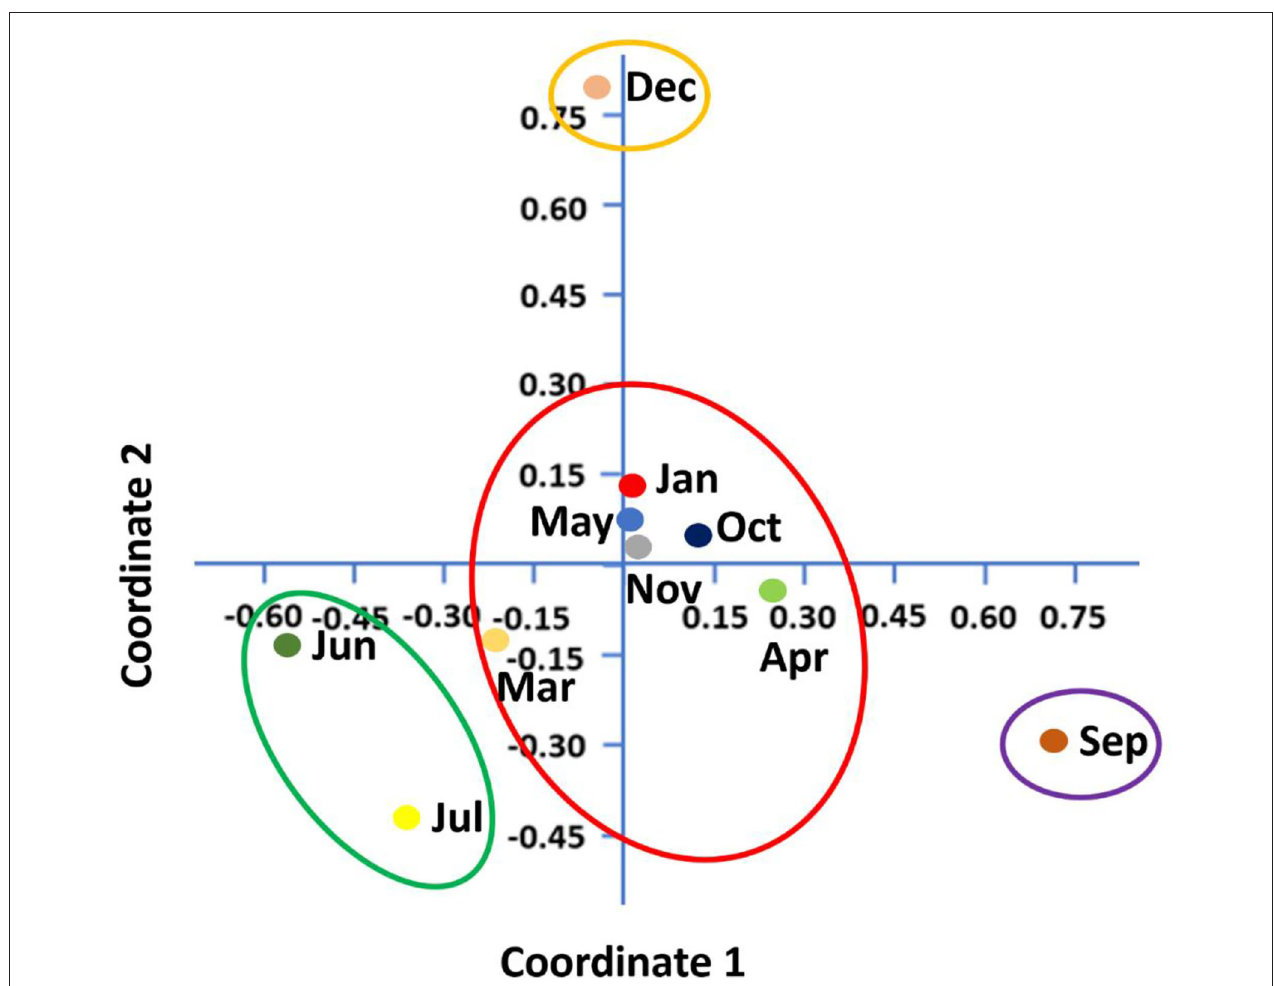
FIGURE 3 | Principal coordinates analysis (PCoA) shows microbial diversity between months in H. dromedarii partially engorged female ticks.